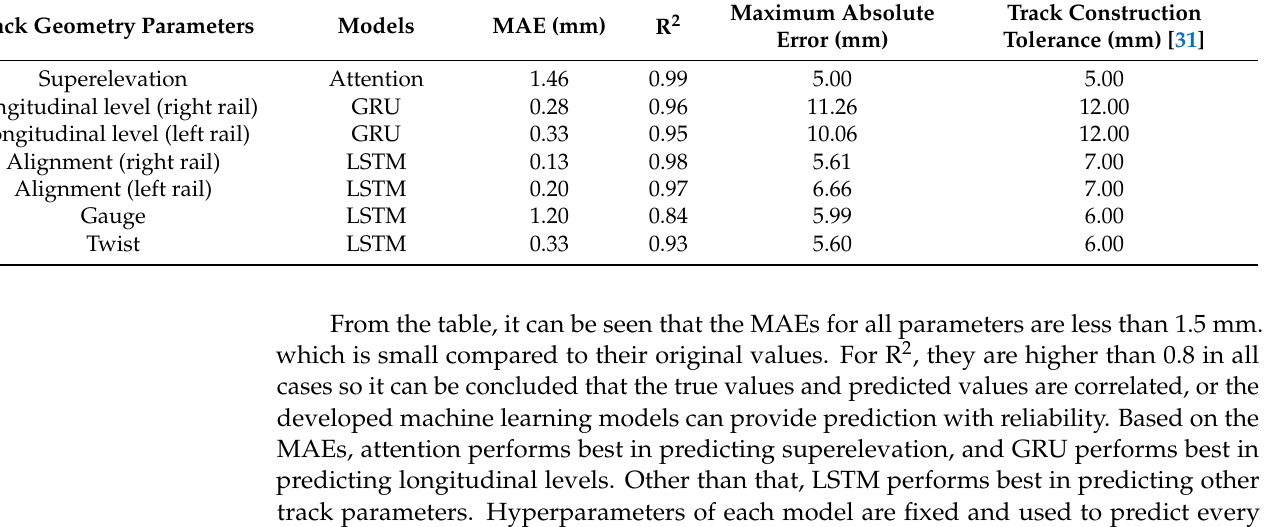
Figure 4. BIM and machine learning integration workflow.